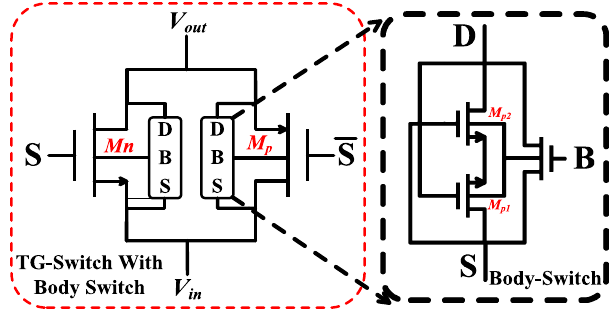
Figure 4. Transmission-gate switch with body switch that was used in the proposed SSC-DVS. Figure 3. The schematic diagram for the proposed n -bit SSC-DVS architecture.